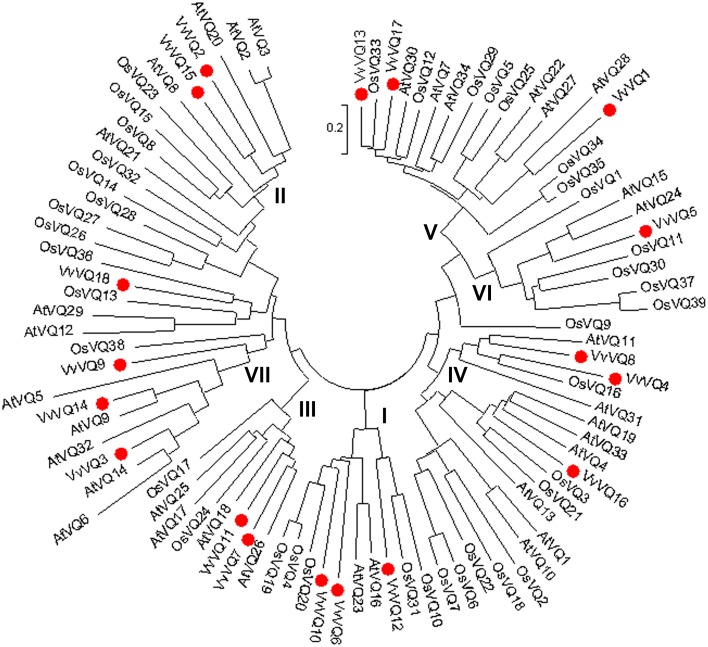
Phylogenetic analysis of Arabidopsis, rice, and grapevine VQ proteins. The unrooted tree, based on the core VQ domains in the three species, was constructed using the Neighbor-Joining (NJ) method (bootstrap 1000 replicates) using MEGA5 software.